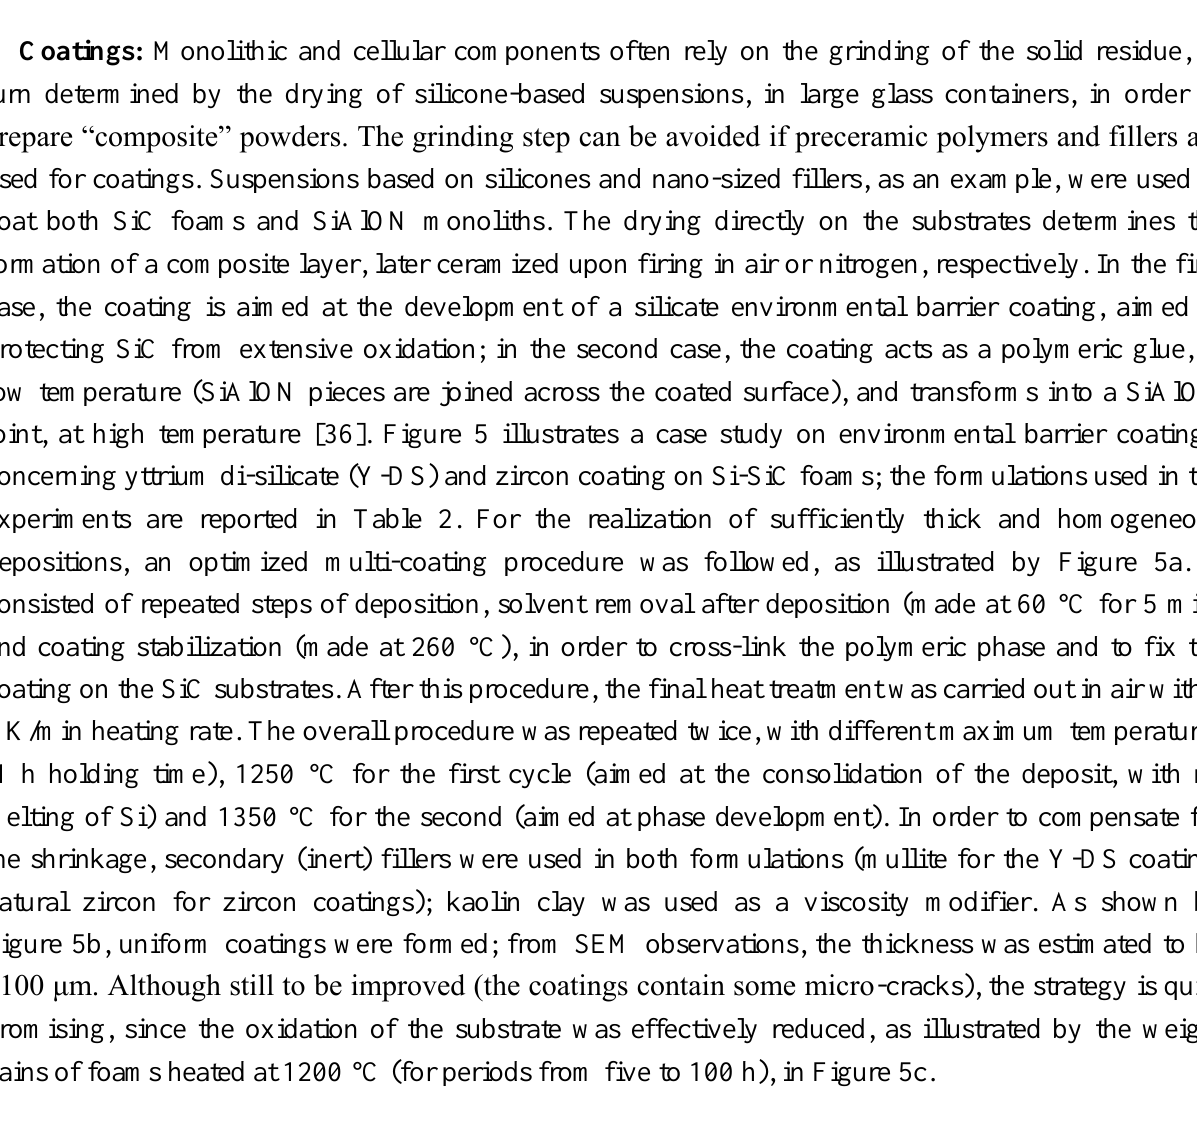
Table 2. Formulations used for the development of silicate coatings on Si-SiC